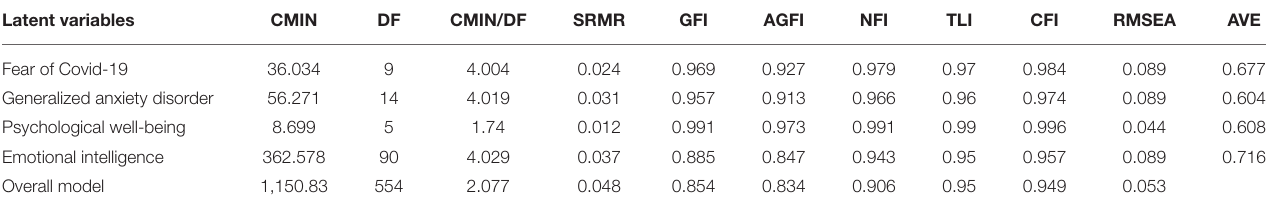
TABLE 3 | Confirmatory factor analysis.